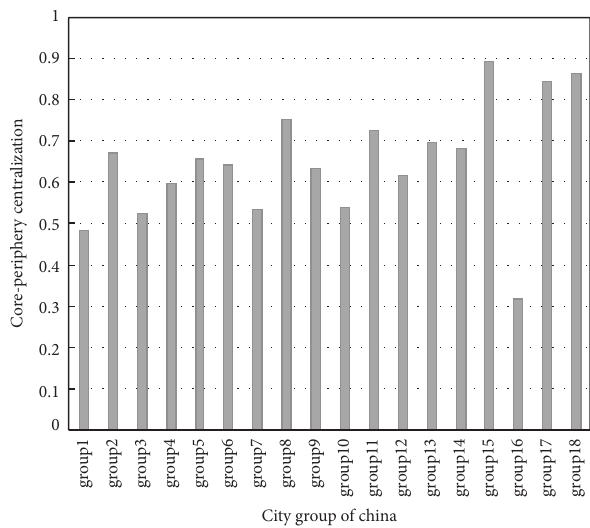
Figure 3: Centralization coefficients of the core-periphery struc- tures of city groups in China.